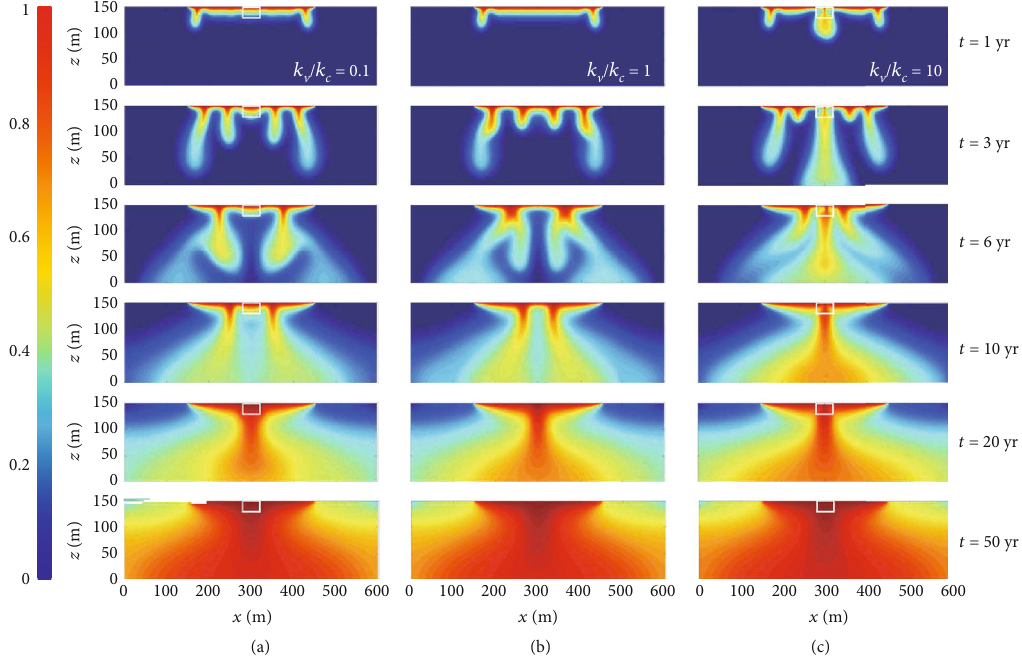
/ k = 0 : 1 , 10) at di ff erent times. The v c